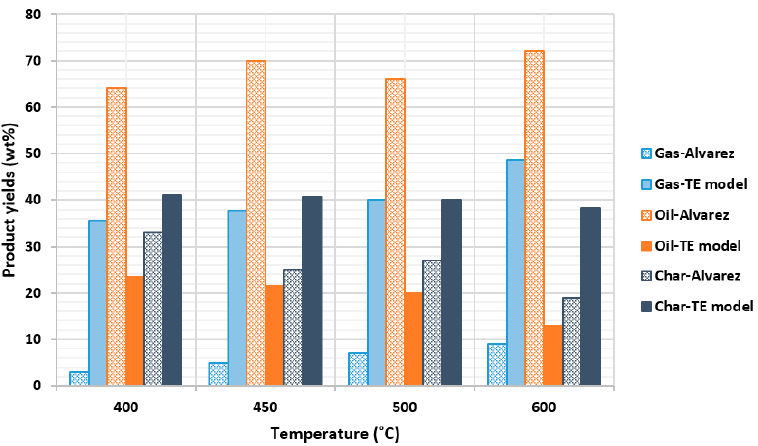
Figure 5. Comparison of product yields (wt%) for rice